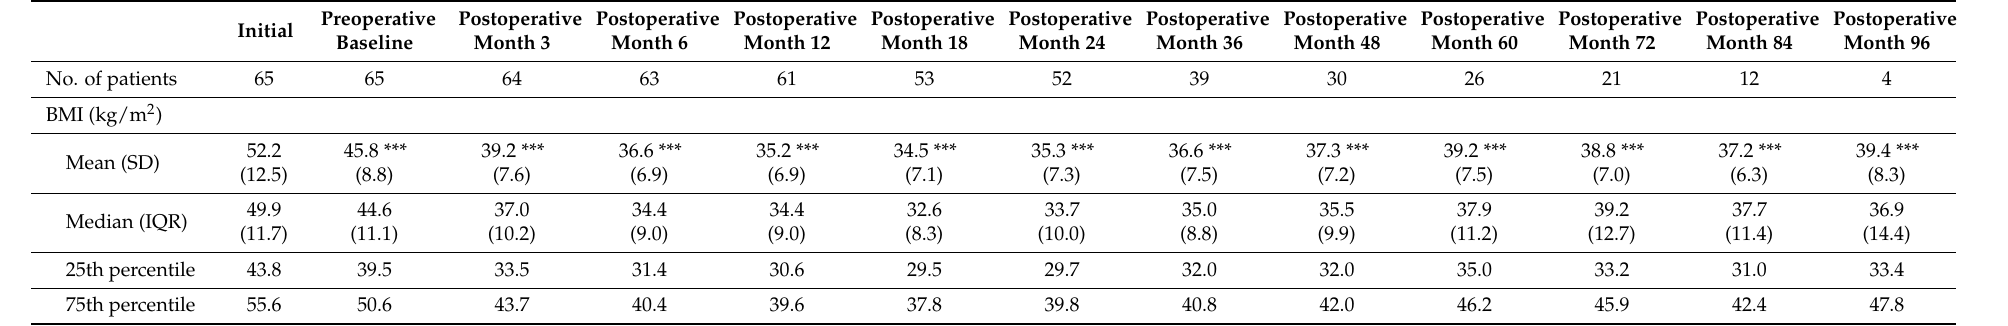
Table 2. Observed mean and median BMI change from initial clinic visit (lifestyle modifications and VLED) to pre-operation and follow-up year 8 after bariatric